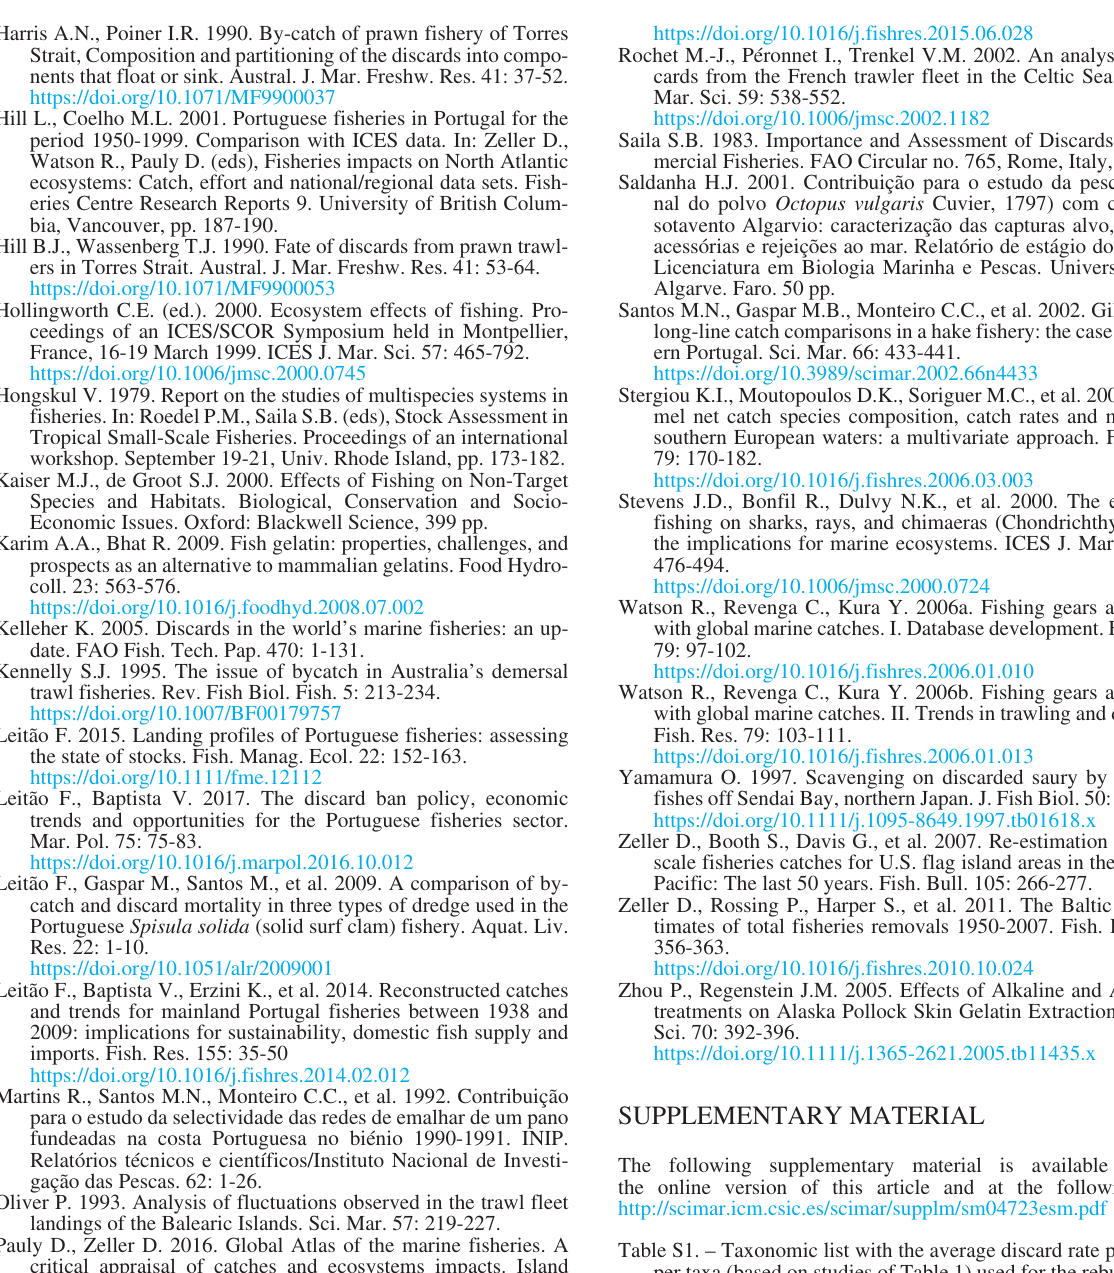
Table S1. – Taxonomic list with the average discard rate per métier per taxa (based on studies of Table 1) used for the rebuilding of unreported catches. Table S2. – Taxonomic list with the average absolute and relative weight contribution of each taxa to total unreported catch, per métier, for the period between 1938 and